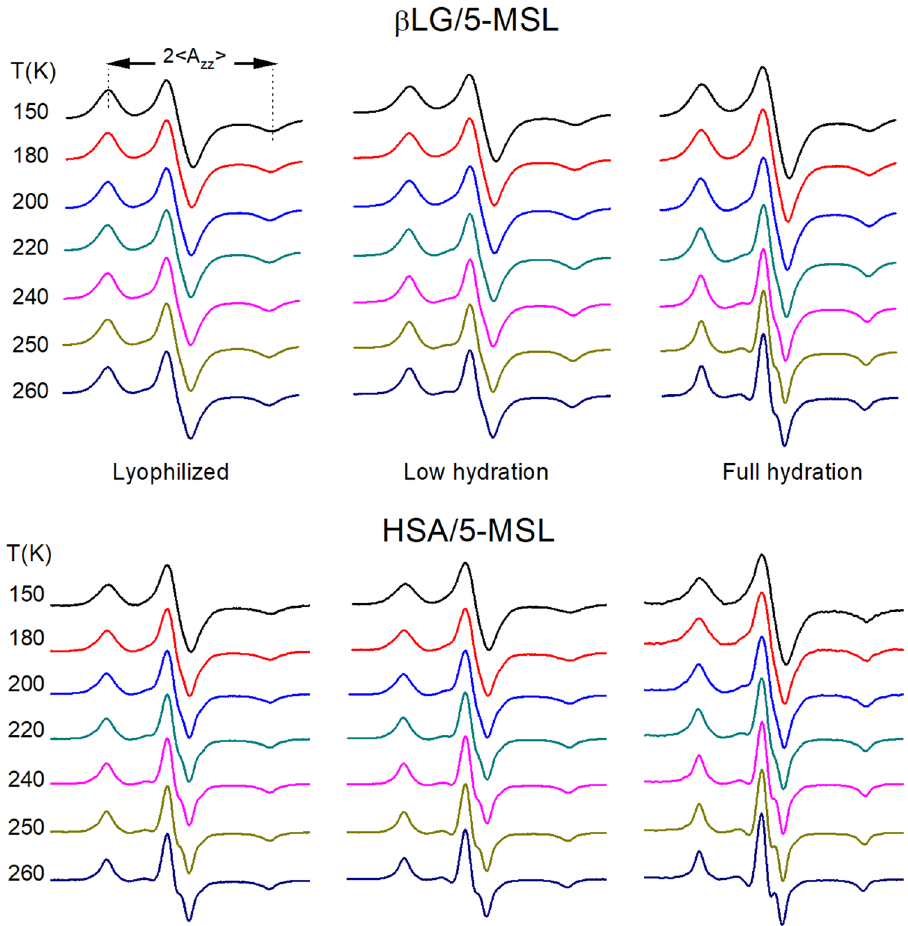
Figure 2: EPR spectra at selected temperatures of β LG/5 - MSL and HSA/5 - MSL at di ff ering hydration states: lyophilized and low hydration and full hydration